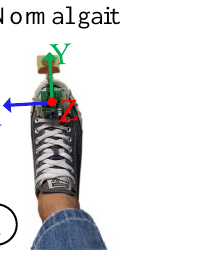
Figure 18. Normal and abnormal foot actions.